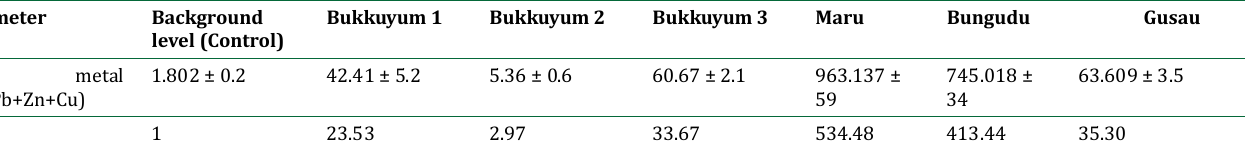
Table 11: Spatial variation of total metals in soils